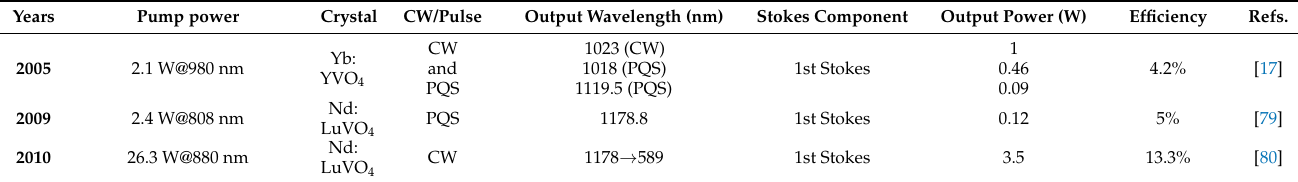
Table 5. Research progress on the Yb:YVO 4 and Nd:LuVO 4 self-Raman